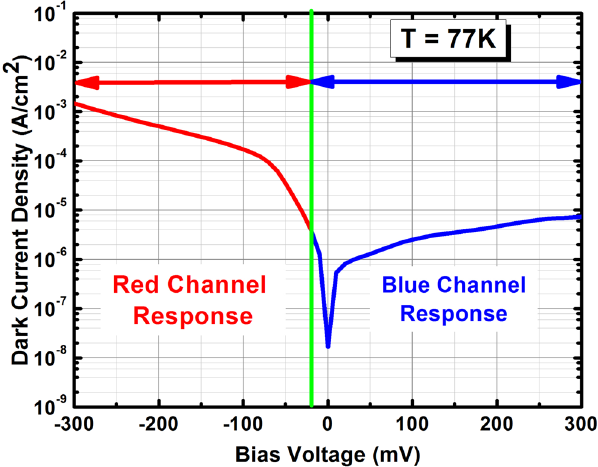
Figure 5. Dark current density vs. applied bias voltage of the dual–band LWIR/VLWIR photodetector at 77 K. The blue and red curves represent the operational bias regimes in which the device acts like a blue and red photodetector,